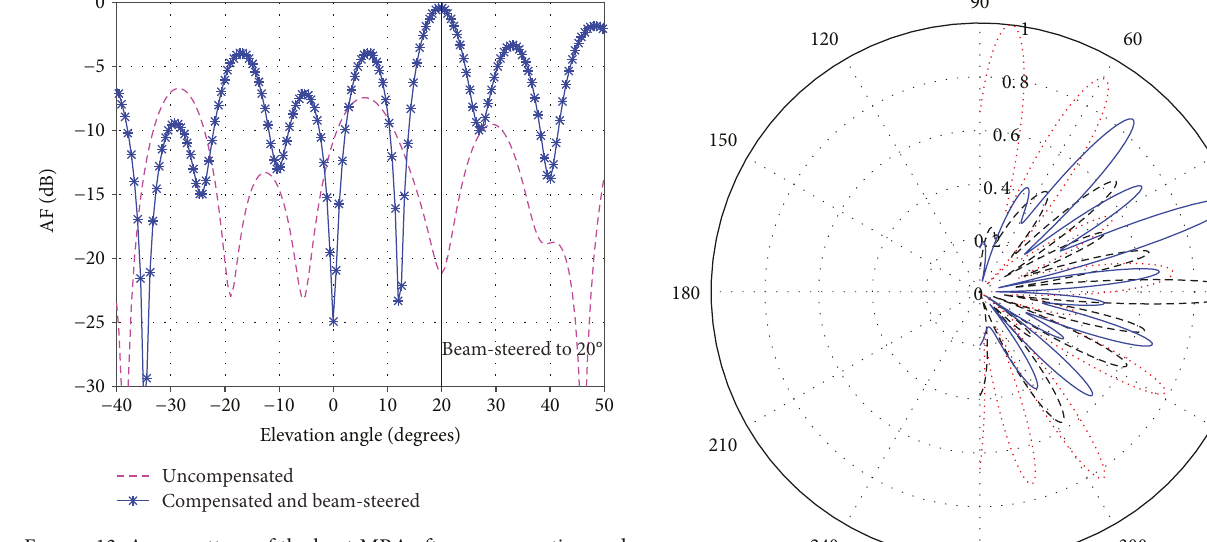
Figure 13: Array pattern of the bent MRA after compensation and beam-steering.